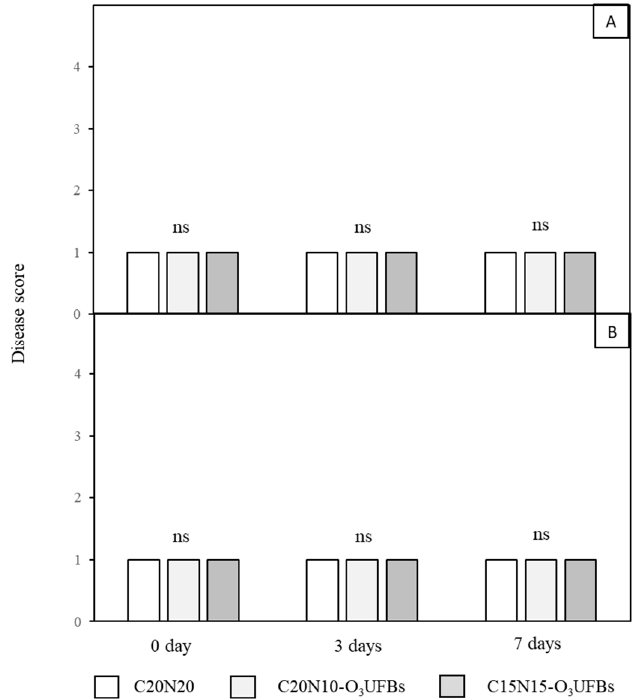
Figure 3. Disease scoring of trimmed coconuts dipped in C 20 N 10 -O 3 UFBs and C 15 N 15 -O 3 UFBs compared with C 20 N 20 when stored at 2 °C for 0 days (before storage) ( A ) and 30 days ( B ). After storage, all coconut fruits were transferred to 8–10 °C for 7 days, and the fruit was evaluated for disease on days 0, 3 and 7. ns: not significantly different.